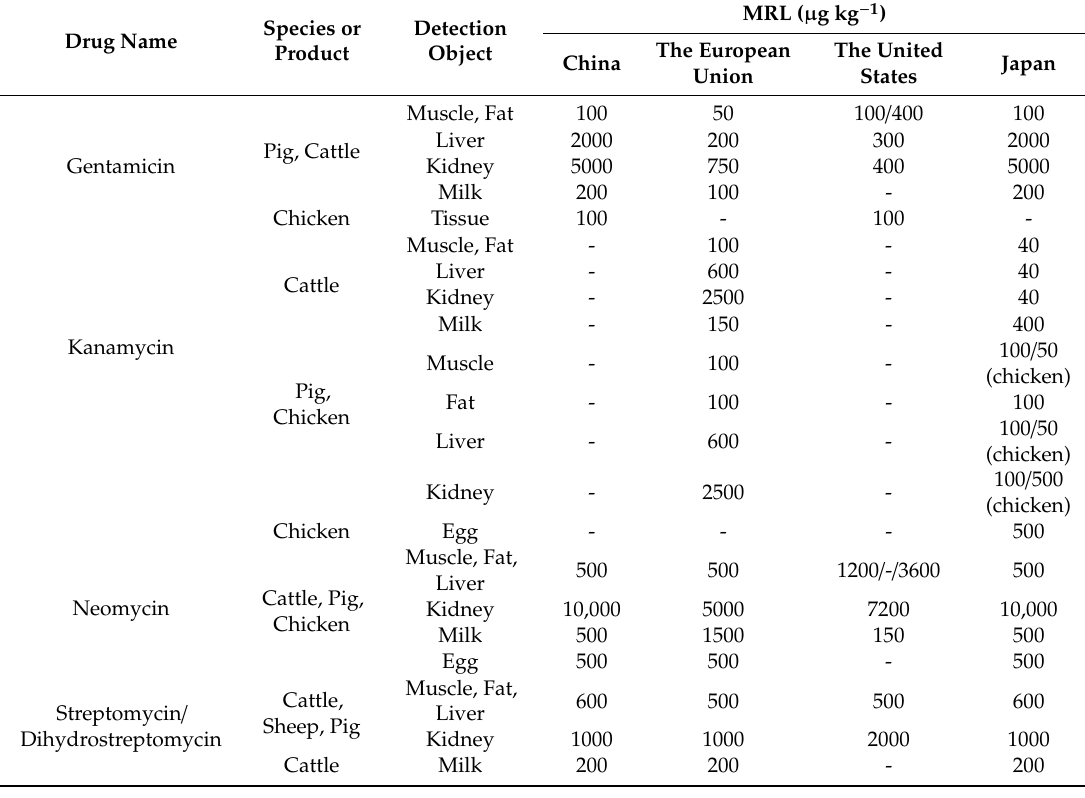
Figure 1. Chemical structure of aminoglycoside antibiotics. Table 1. Maximum residue limits (MRLs) of some aminoglycosides in various countries.